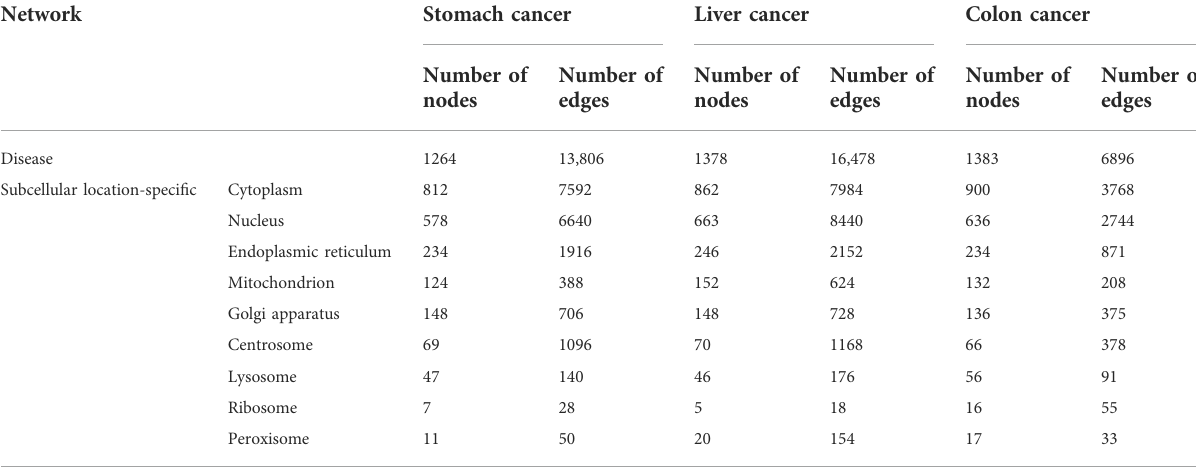
TABLE 2 Scale of disease and subcellular location-speci fi c networks for stomach, liver, and colon cancers.